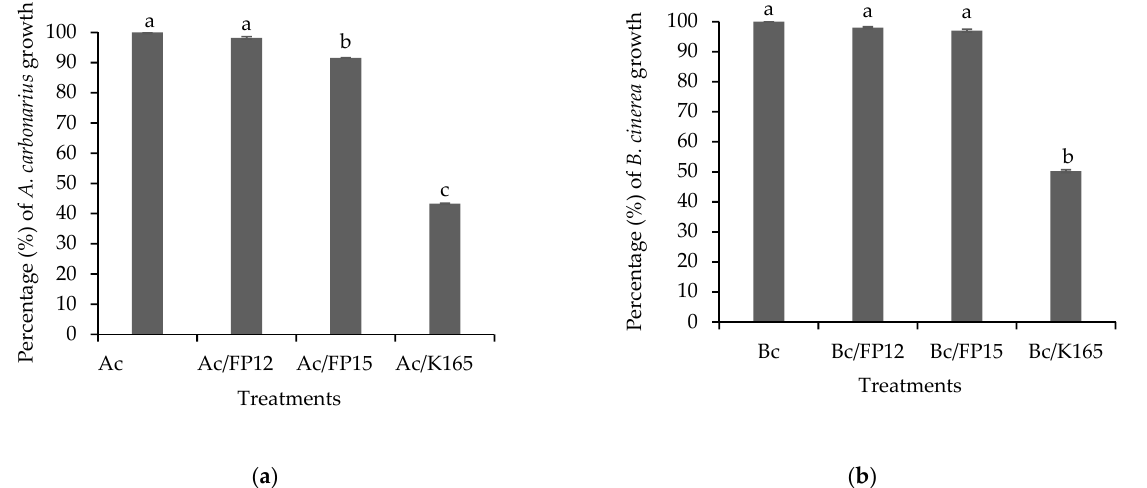
Figure 1. In vitro growth of Aspergillus carbonarius , Ac, ( a ) and Botrytis cinerea , Bc, ( b ) in dual culture with K165, FP12 and FP15 in PDA medium at 7 days after inoculation. The growth of the pathogen in the single culture (Ac or Bc) was set to 100% and its growth in the dual cultures was estimated as a percentage relative to the growth in the single culture. The columns represent the means of two biological repeats with three plates per treatment and repeated experiments ( n = 6). Columns with different letters are significantly different from each other, according to Tukey’s multiple range test ( p < 0.05). The vertical bars indicate the standard error